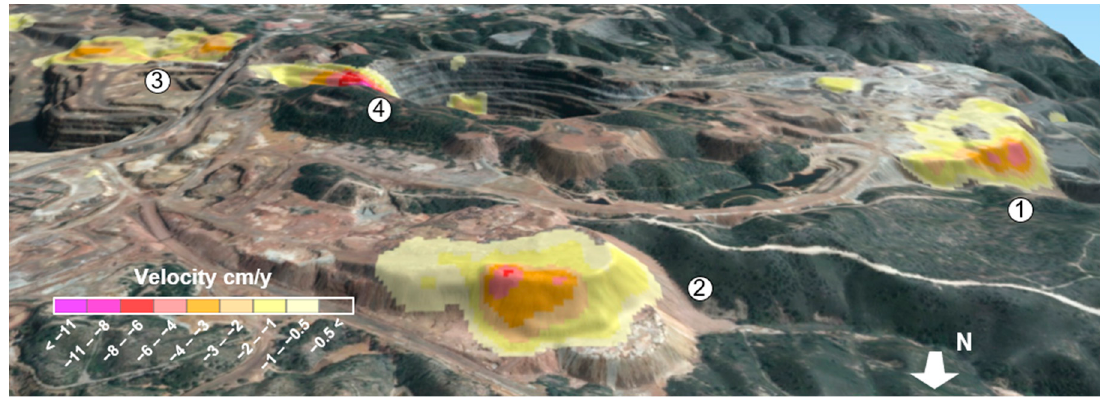
Figure 11. North-South view of the passive mining elements. The numbers are the four zones un- der discussion.